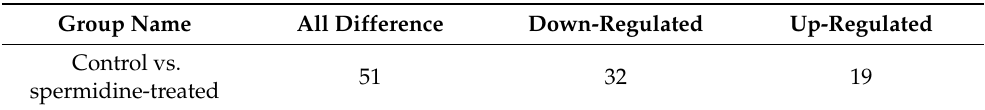
Figure 5. Effects of spermidine on intestinal metabonomic characteristics. ( A , B ) PCA of intestinal metabolites in the mice. ( C ) OPLS-DA of intestinal metabolites in the mouse colons. ( D ) Volcano diagram of the differential metabolites in the colon contents of the mice. ( E ) Significantly different metabolites participate in the classification of metabolic pathway enrichment. In this figure, AP is the control group and CP is the HSPD group. Table 2. Number of differential metabolites in the colon contents of the spermidine-treated and control groups.